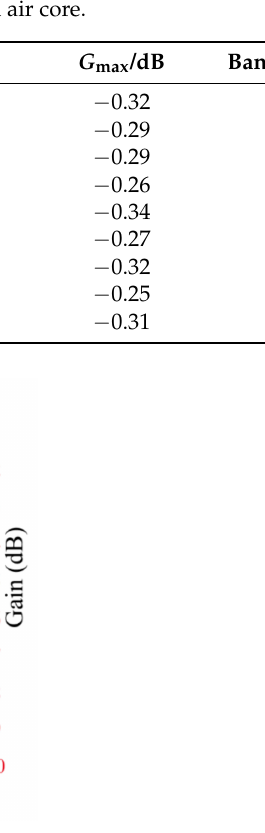
Figure 3. Calculated inductance and maximum available gain of solenoidal transformer with air